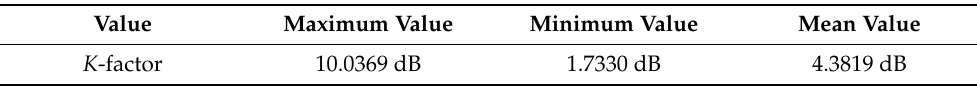
Figure 6. Cumulative distribution function (CDF) of K -factor from LCX MIMO channel measurements. Table 5. Estimate values of K -factor from the measurements.